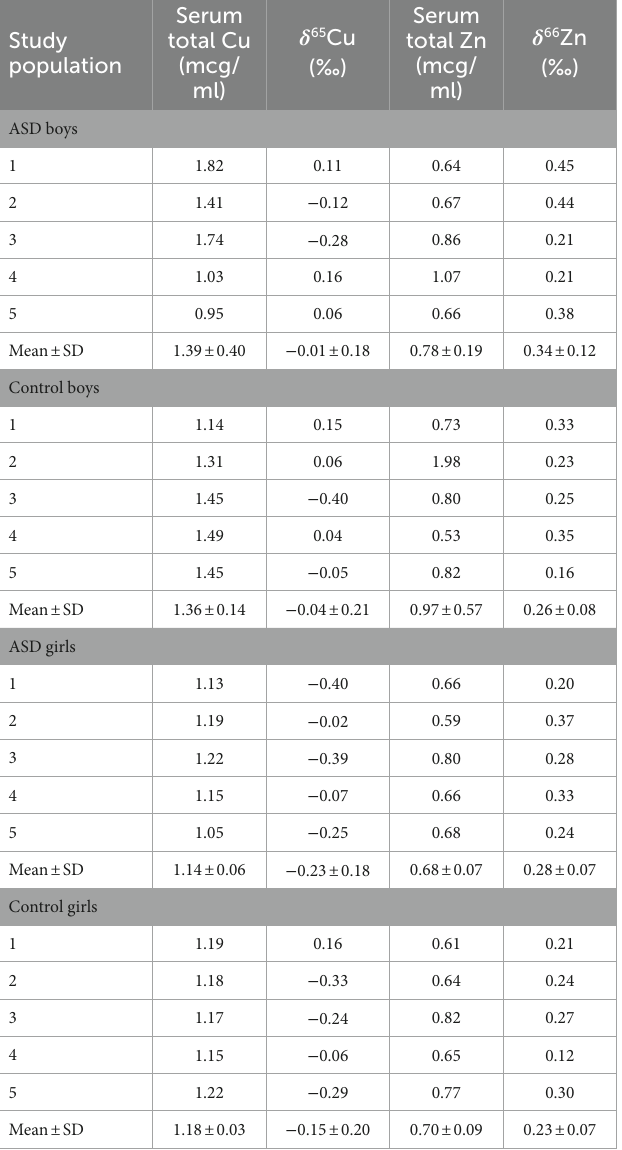
TABLE 2 Total Serum Copper and Zinc and Copper δ 65 and Zinc δ 64 results for controls and children with ASD.